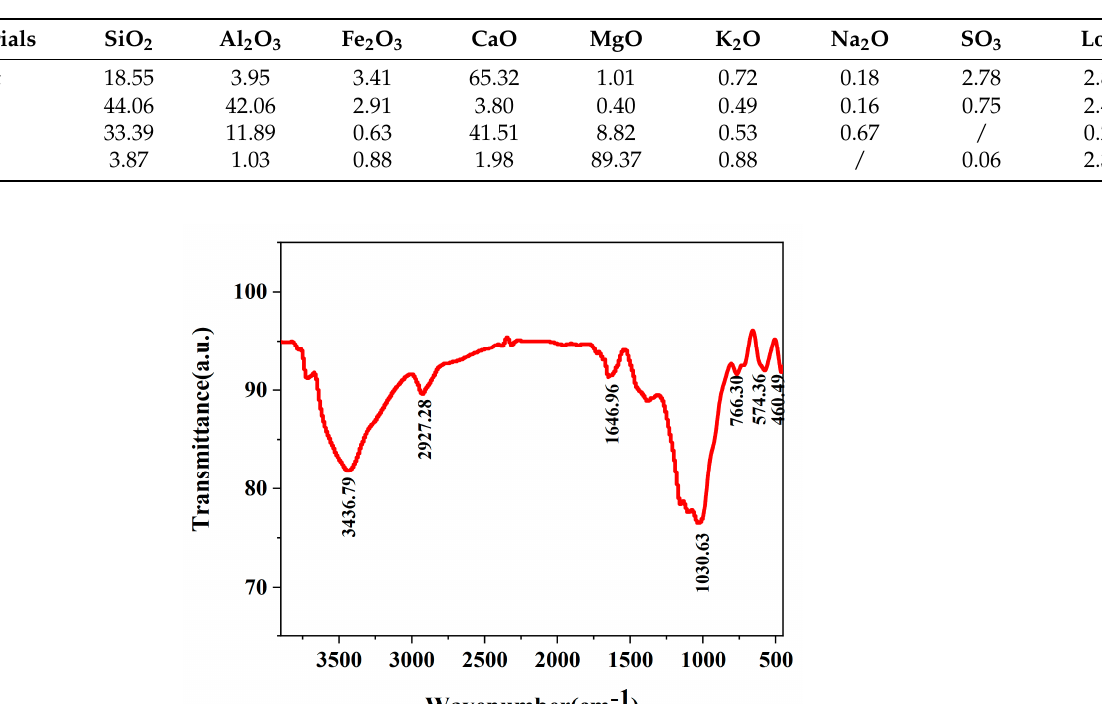
Table 1. Chemical composition of raw materials/%.